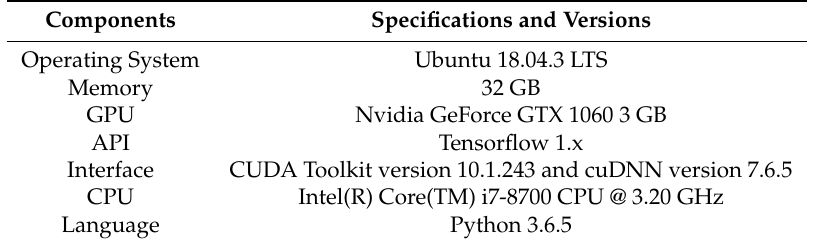
Table 1. Components and specifications with versions of the system used for